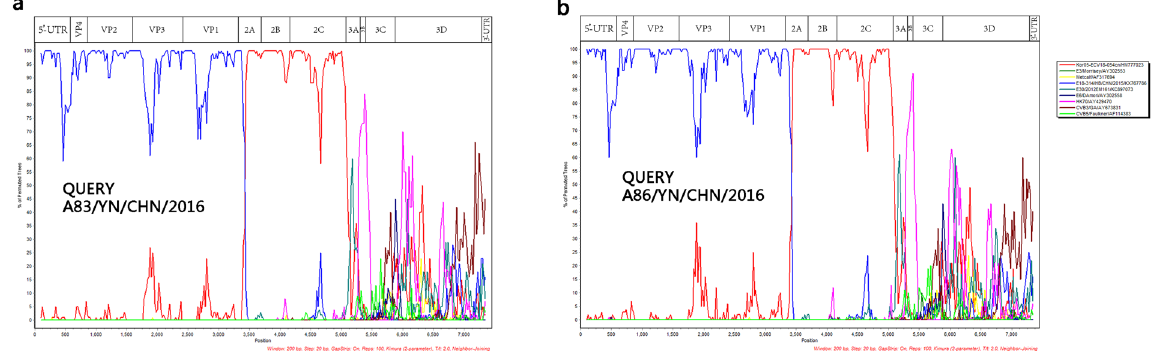
Figure 6. Bootscanning analyses of the complete genome of the two Yunnan E-18 strains. Bootscanning analysis of complete EV-B genomes using a sliding window of 200 nt moving in 20-nt steps. The two Yunnan strains were used as query sequences